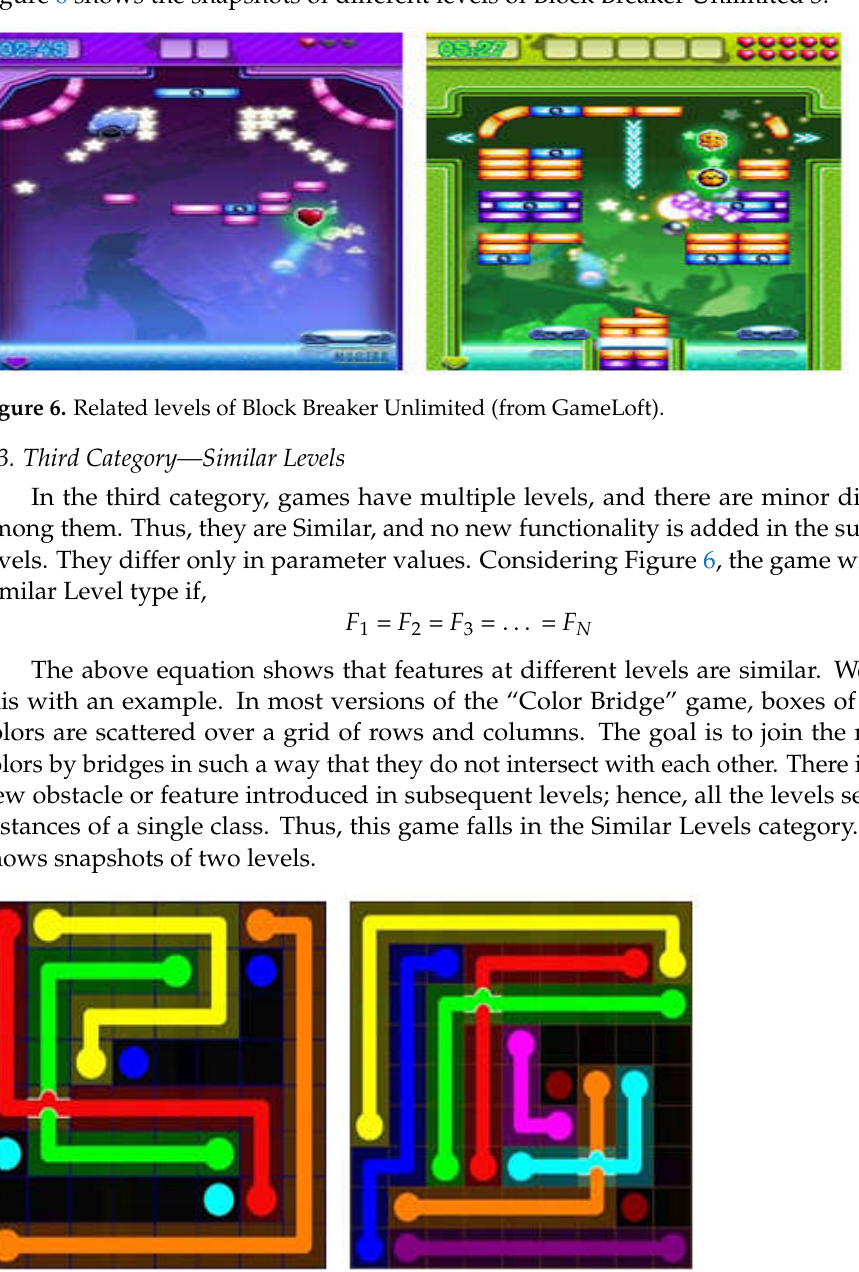
Figure 7. Similar levels of the Color Bridge game.